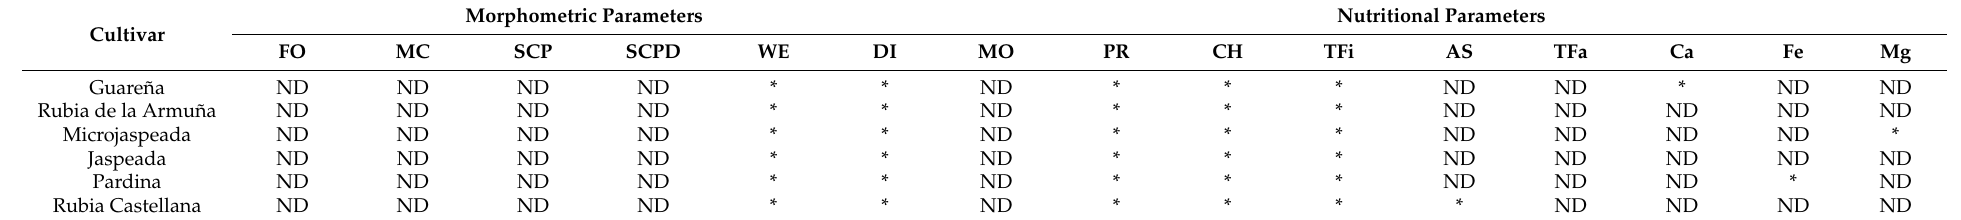
Table 6. Growing season’s differences in the morphometric and nutritional parameters of the studied